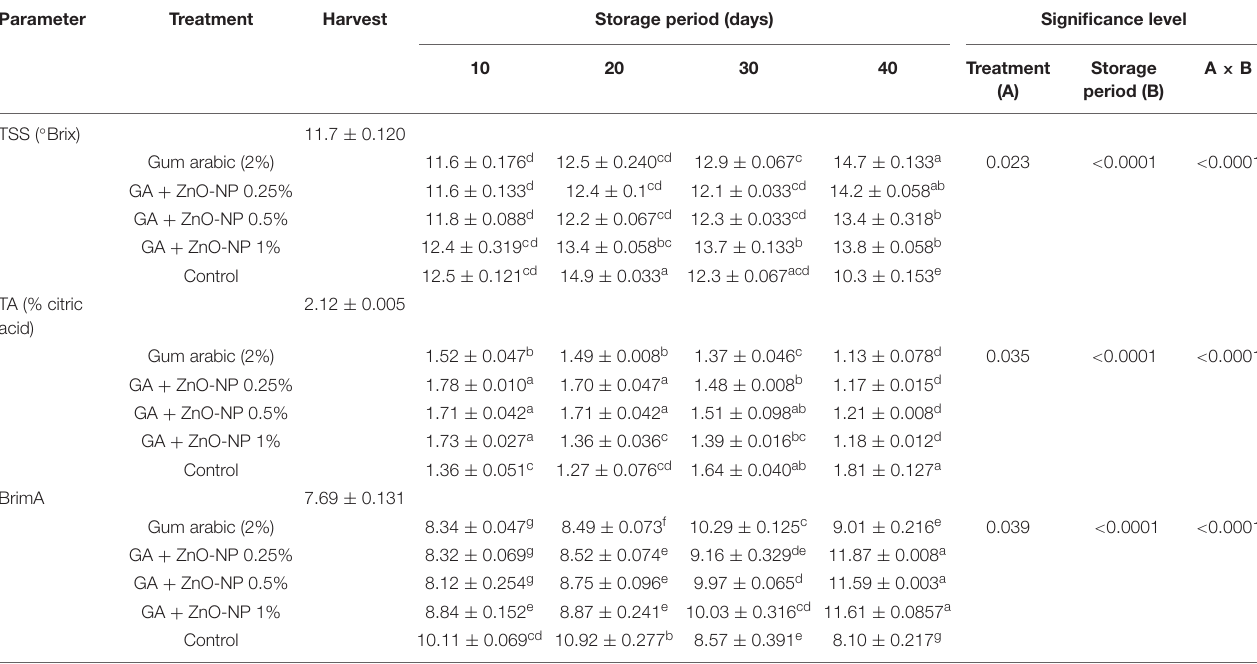
TABLE 1 | Total soluble solids (TSS), titratable acidity (TA), and BrimA index of ’Kinnow’ mandarin fruit treated with gum arabic coating fused with zinc-oxide nanoparticles during storage for 40 days at 5 ± 1 ◦ C.